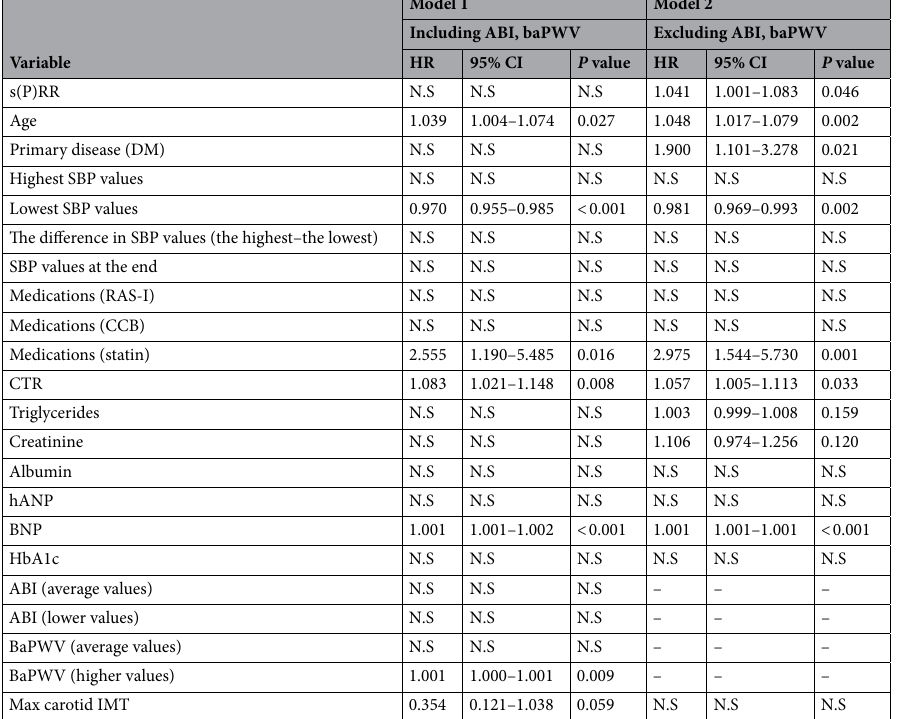
Table 5. Multivariate Cox regression analyses of variables for cardiovascular deaths. ABI, ankle-brachial index; baPWV, brachial-ankle pulse wave velocity; HR, hazard ratio; CI, confidence interval; s(P)RR, soluble (pro)renin receptor; N.S., not selected as a potential covariate; DM, diabetes mellitus; SBP, systolic blood pressure; RAS-I, renin-angiotensin system inhibitor; CCB, calcium channel blocker; CTR, cardiothoracic ratio; CRP, C-reactive protein; hANP, human atrial natriuretic peptide; BNP, brain natriuretic peptide; IMT, intima- media